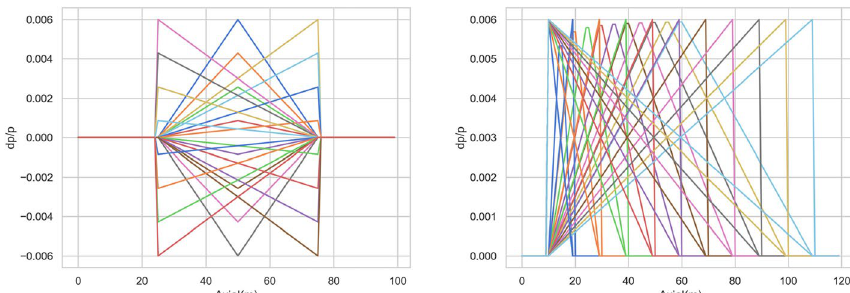
Fig. 6 Amplitude and length perturbations of different waves